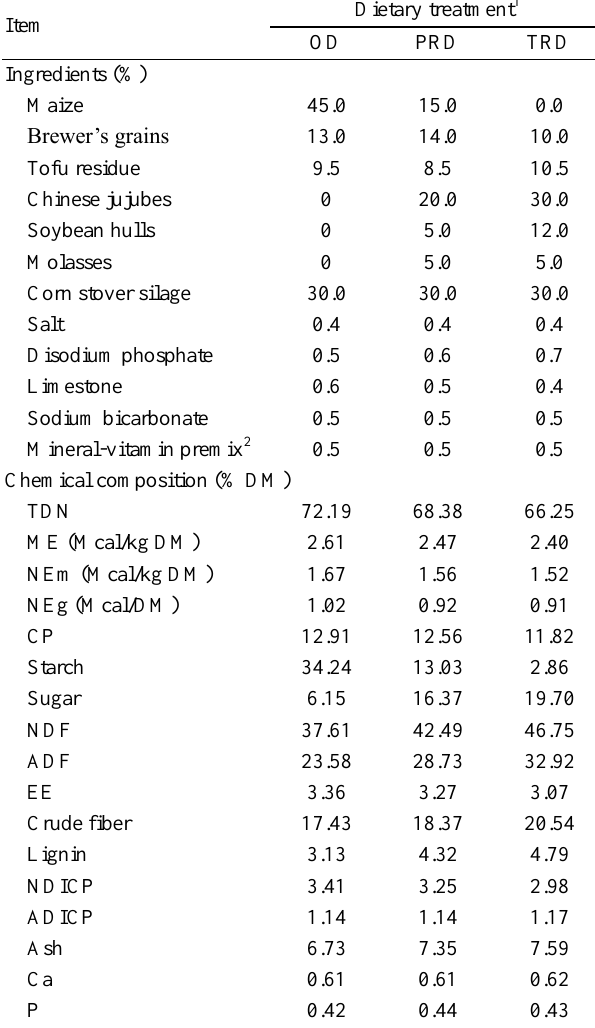
Dietary treatment 1